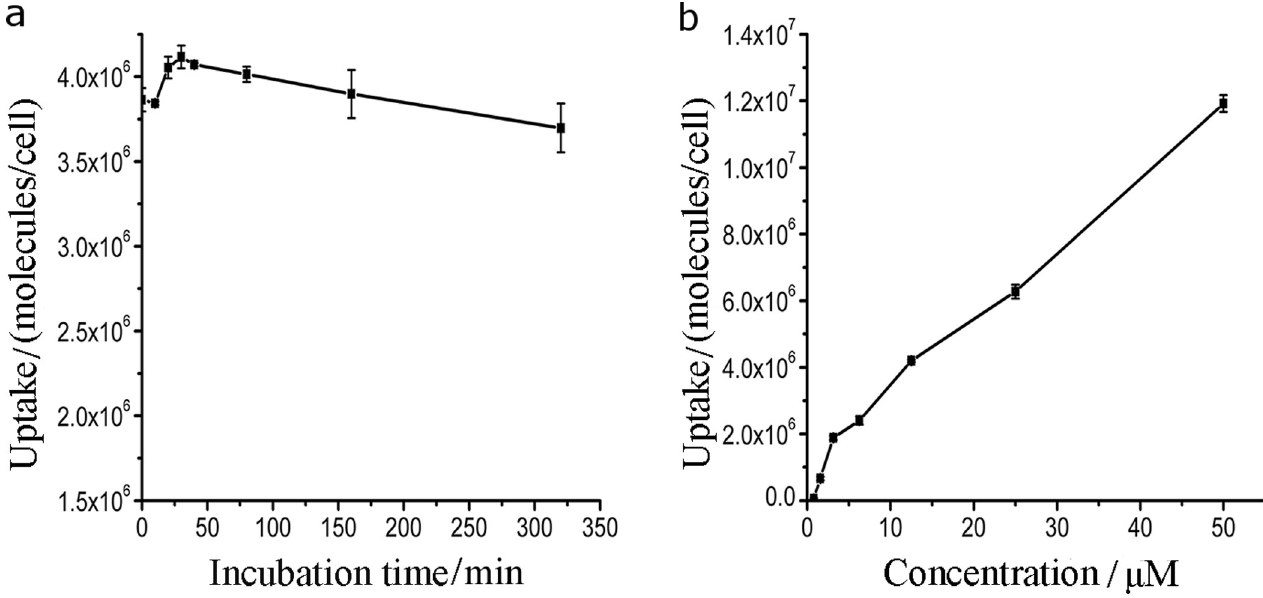
Fig 4. Uptake of protoporphyrin IX–ethylenediamine derivative (PPIX-ED) by Pseudomonas aeruginosa in relation to the incubation time and concentration. The uptake was evaluated using a fluorescence assay. (a) The bacterial culture was incubated with PPIX-ED (6.25 μ M) for 320 min or with (b) PPIX-ED at a final concentration of 3.13–50.0 μ M in the dark for 30 min at ambient temperature.